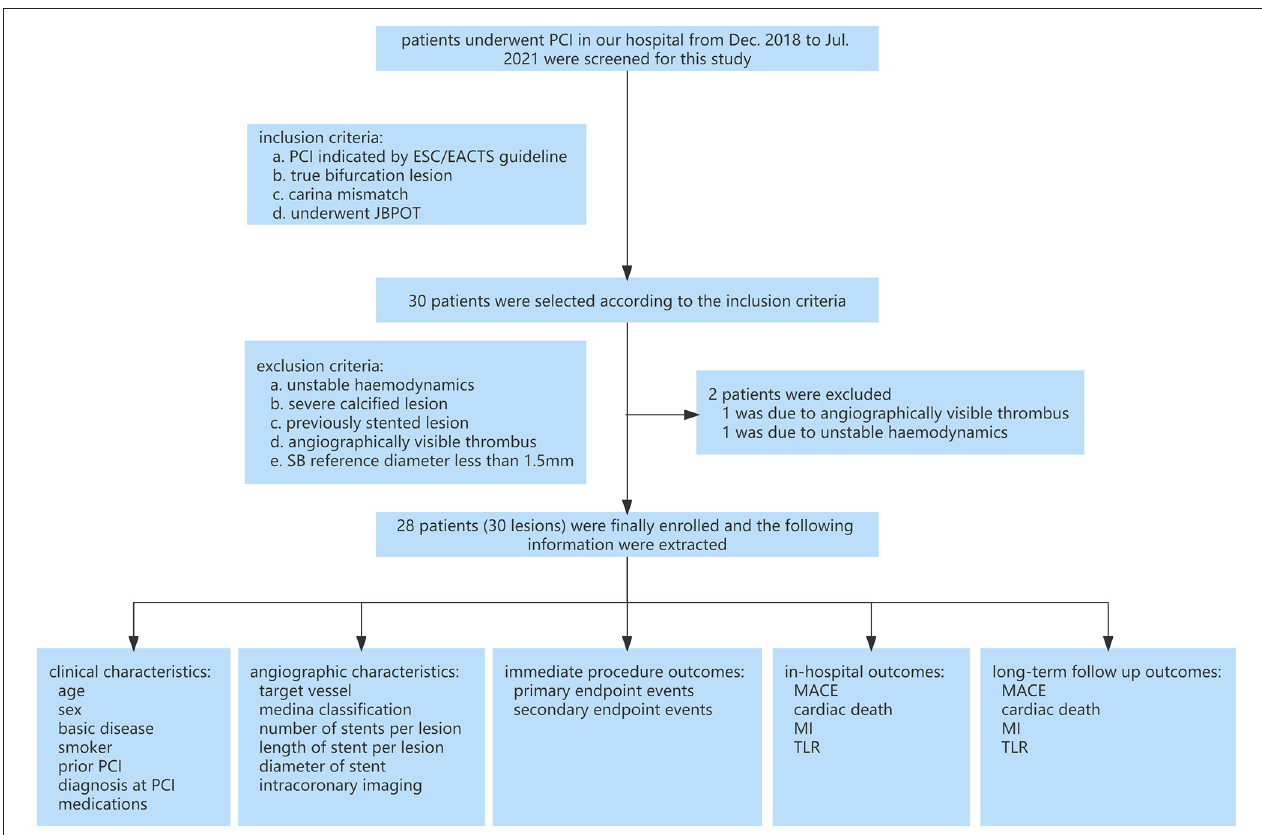
FIGURE 3 | Clinical study flowchart. PCI, percutaneous coronary intervention; ECA, European Society Of Cardiology; EACTS, European Association For Cardio Thoracic Surgery; JB-POT, balloon-jailed proximal optimization technique; MACE, major adverse cardiovascular events; TLR, target lesion revascularization; MI, myocardial